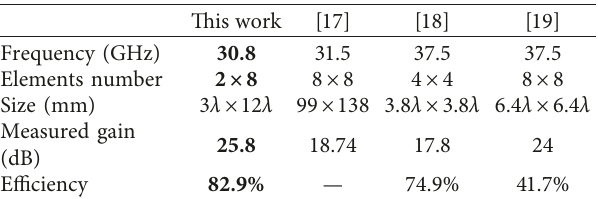
Figure 13: Measured and simulated frequency characteristics of the Table 1: Comparison with previously reported Ka-band antenna arrays.